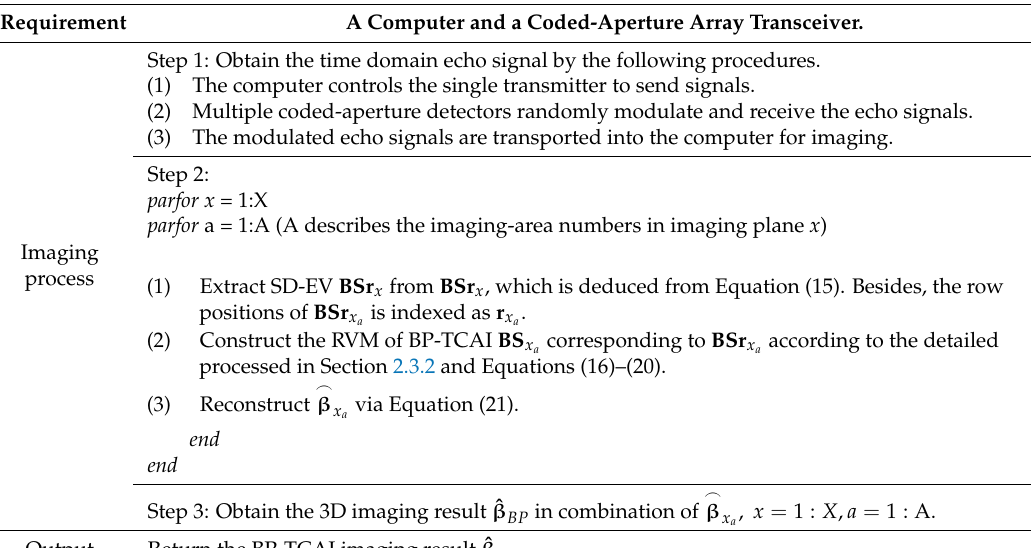
Table 3. Imaging procedure of back projection